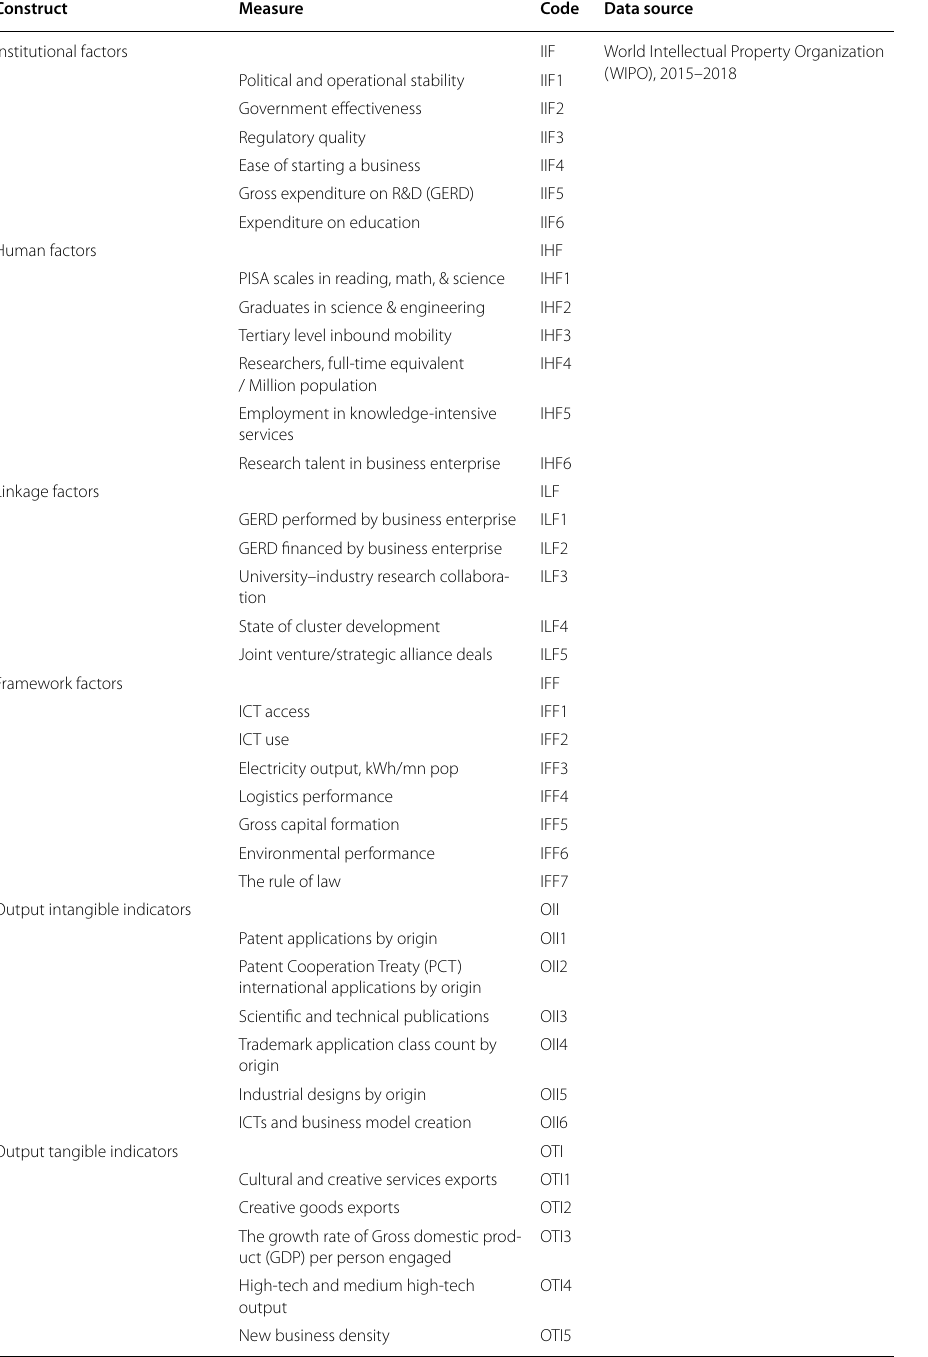
Table 1 Factor measures and data source Construct Measure Code Data